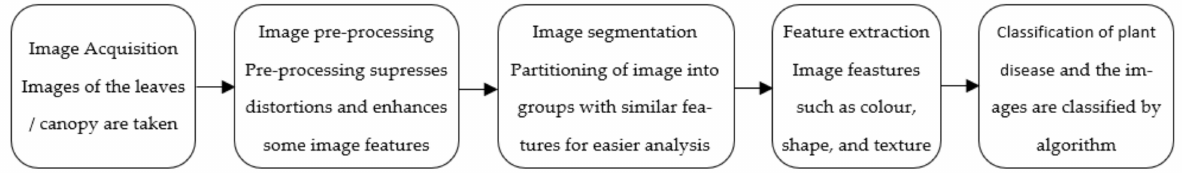
Figure 3. Steps in spectral signature analysis for plant health